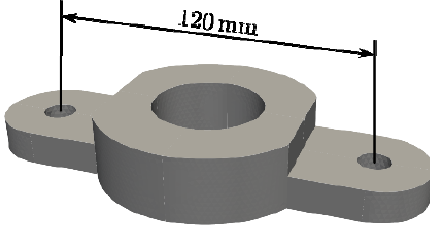
Figure 1. Sample geometry Sintering temperature profile considered within the simulation started from ambient temperature of 20°C,